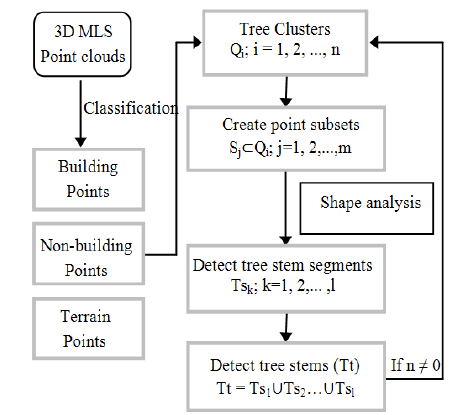
Figure 2. Workflow for tree stem